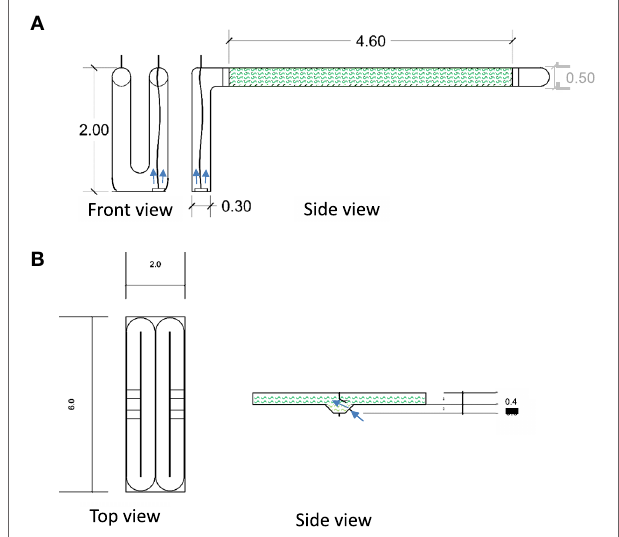
FigUre 1 | Design and specifications of pilot-scale (a) tubular PBr (1:35 scale) and (B) two open raceway ponds (1:75 scale) . A 2-m-long U-shaped PVC pipe with 0.3 m diameter was used as the airlift for the PBR that was connected to clear 4.6 m polyethylene flexible tubes that were also connected to a PVC bend at the end. Two 6-m-long open raceway ponds were constructed using fiberglass-coated plywood. Mixing was achieved by aeration with pressurized air using airlifts (arrows). This included an aeration disk with 6000 exit holes for the PBR and a single exit point for pressured air at a lowered section of the raceway ponds. Specifications are shown in